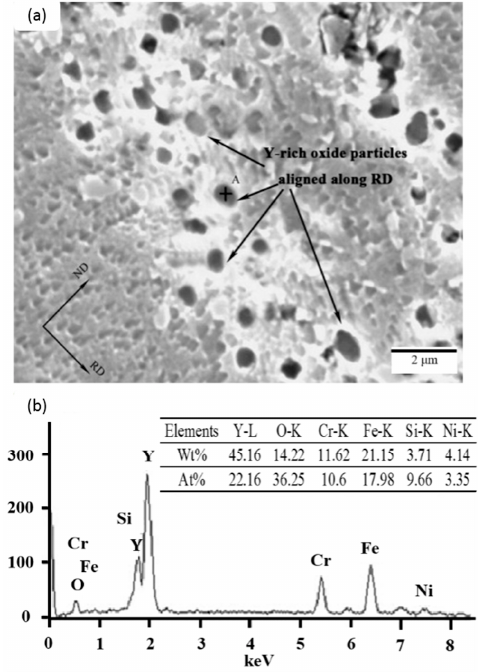
Figure 11. ( a ) SEM image of fine spherical particles aligned along the rolling direction of steel with RE metals, and ( b ) corresponding EDS for spherical particles (point A indicates a particle) [58].